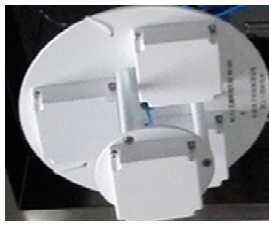
Figure 4. Array antennas. Figure 4. Array